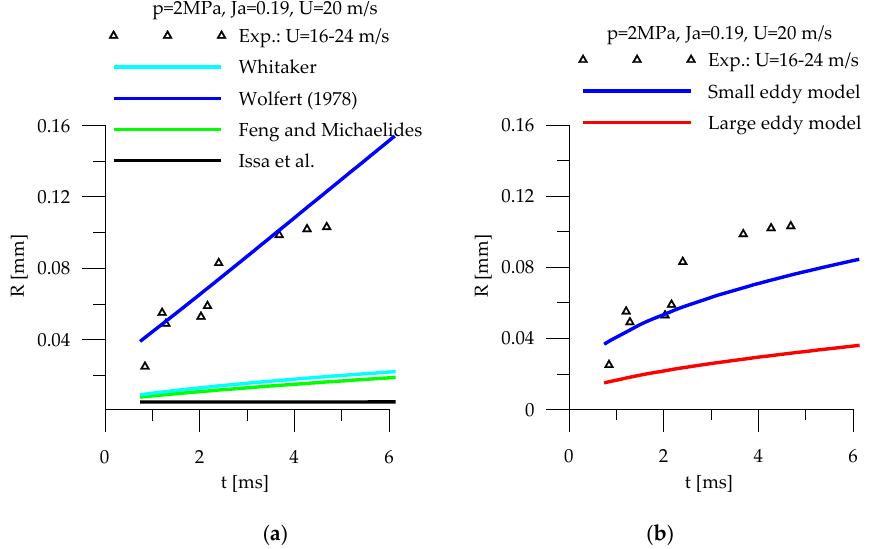
Figure 13. Simulated and measured bubble radius at turbulent conditions (experimental data from [74]): ( a ) Empirical correlations. ( b ) Theoretical